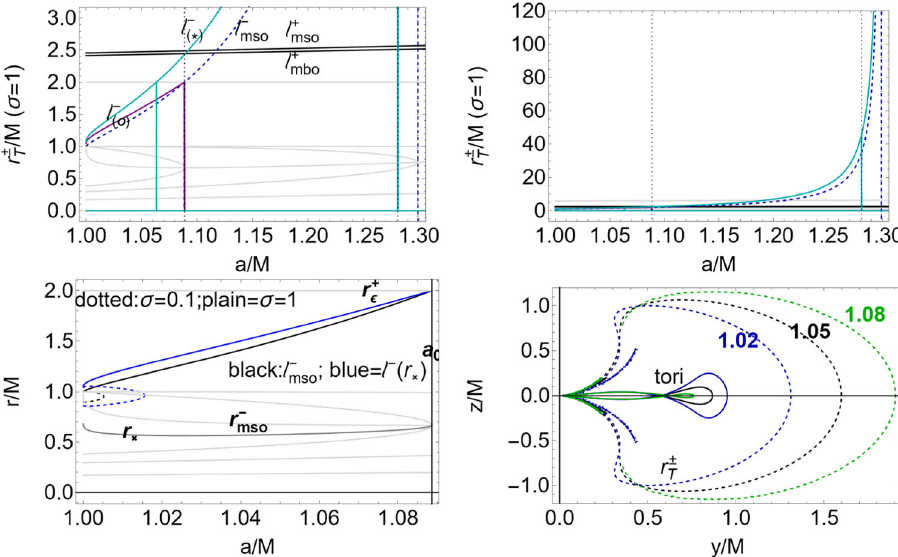
Fig. 16 Upper line: Inversion radius r ± (cid:2) on the equatorial plane σ = 1 fluid momentum), on r − δ there is E = 0 (energy of test particle circular < 0 are the specific angular momenta for as function of the NS spin-mass ratio a / M . (The most general solutions orbits). (cid:6) + mso < 0 and (cid:6) + mbo r ± (cid:2) , further constraints are in Sect. 3.2.) Gray curves are the Kerr NS fluid with (cid:6) = (cid:6) + < 0 on the marginally stable orbit and marginally geodesic structure. The inversion radius is evaluated on different flow bounded orbit respectively. Bottom left panel: light-gray curves are the specific angular momenta (cid:6) , signed on the curves. For (cid:6) − > 0 inver- geodesic structure for a < a 0 , blue and black curves are the inversion sion points are only for space-like particles with ( E < 0 , L < 0 ) in the radius for particle flows with (cid:6) = (cid:6) − mso > 0 and (cid:6) − ( r × ) > 0 signed conditions of Sec. (C). Left panel is a close-up view of the left panel. on the panels. Radius r + (cid:11) = 2 M is the outer ergosurface on the equato- ≡ (cid:6) − ( r − ) where r − ≡ r − − ( r − − r − )/ 2, while There is (cid:6) − ( rial plane. Bottom right panel: tori (plain curves) and inversion points δ ( o ) ( o ) mso mso o ) (cid:6) − ≡ (cid:6) − ( r − ) where r − ≡ r − − ( r − − r − )/ 2. Radius r − (dashed curves) for selected values of the NS spin-mass ratios a / M ( ∗ ) ( ∗ ) ( ∗ ) mso mso mso is the 0 signed on the panels, according to the tori models of the left panel. (cid:6) marginally stable orbit for fluids with specific angular momentum (cid:6) − , z 2 + y 2 and σ ≡ sin 2 θ = y 2 /( z 2 + y 2 ) There is r = on r − there is L = (cid:6) = 0 (test particle circular angular momentum and 0